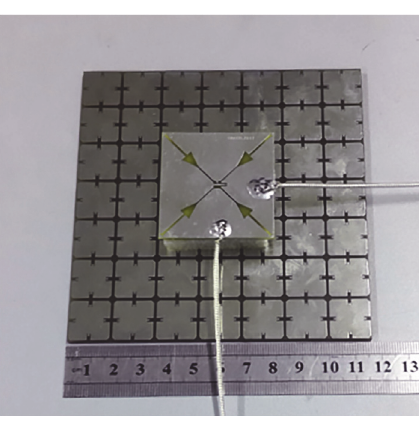
Figure 11: Photograph of the proposed dual-polarized slot antenna.